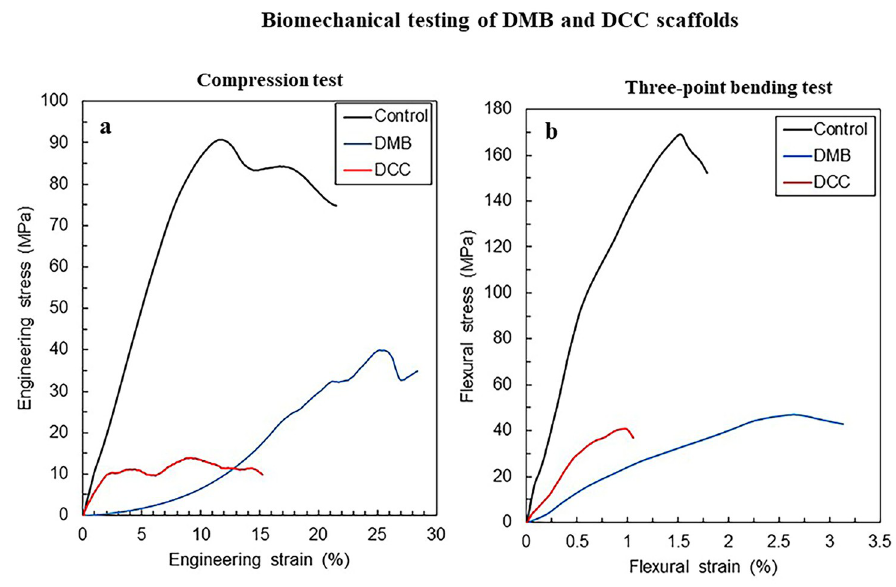
Fig 7. Stress-strain curve of scaffolds in the compression test. Representative images of compressive engineering stress and engineering strain (SS) curves of native control bone, DMB, and DCC scaffolds; n = 6 (a). Flexural-strain curve of scaffolds in three-point bending test. Representative images of flexural stress and strain curves of native control bone, DMB, and DCC scaffold; n = 6 (b).